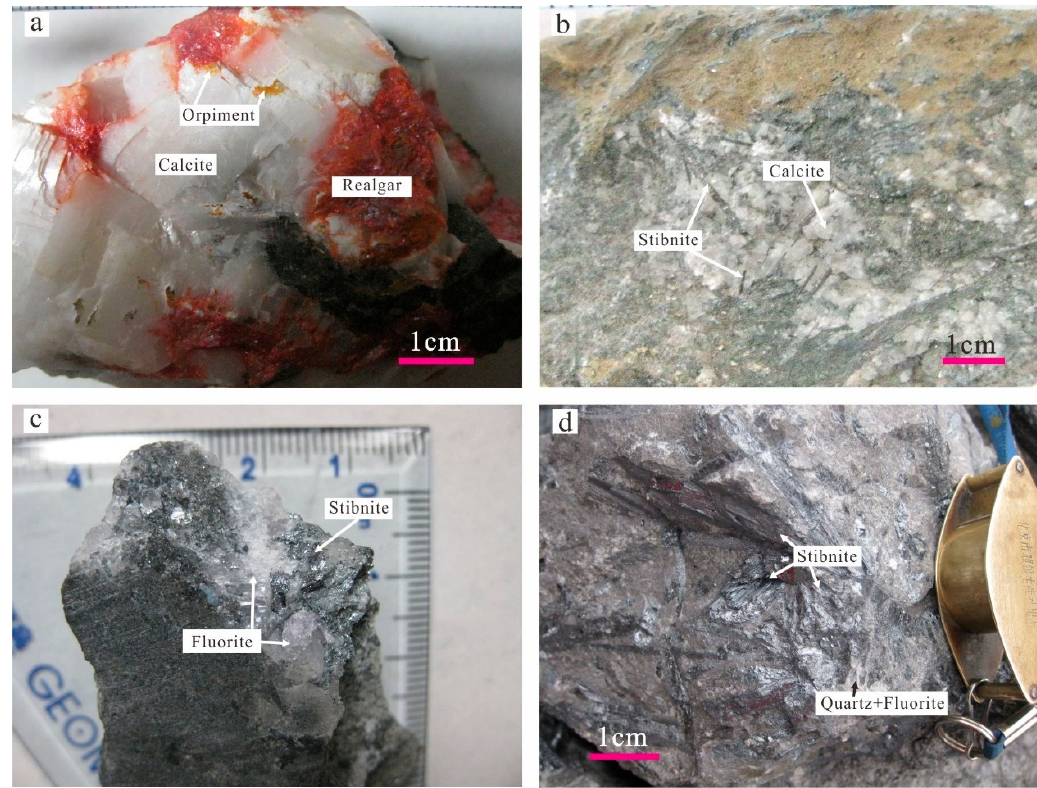
Figure 4. Photographs of calcite ( a , b ) and fluorite ( c , d ) from the Zimudang Au deposit and Dachang Sb deposit, respectively.